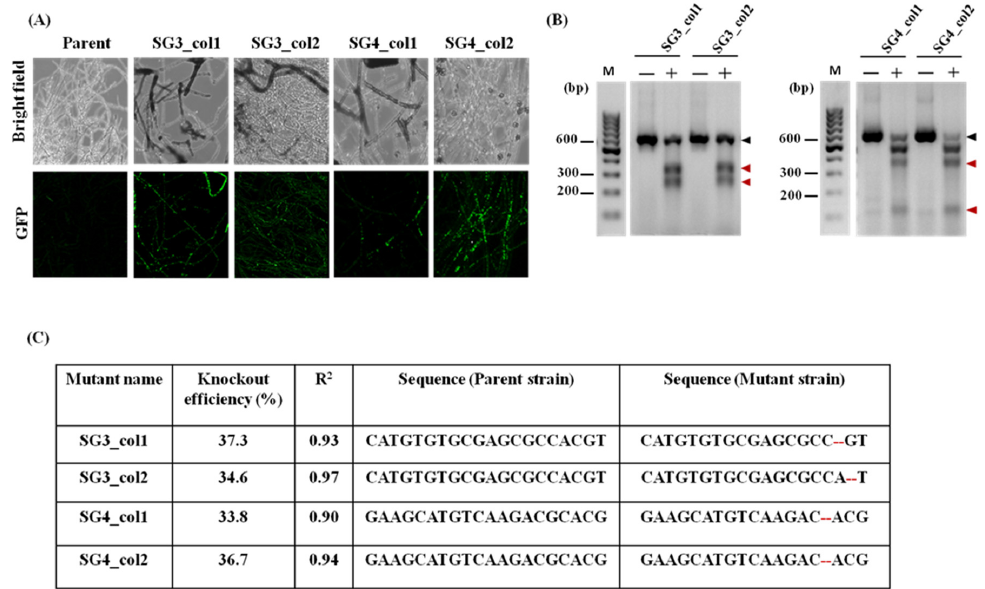
Figure 3. Generation of pacC mutants of T. rubrum IGIB-SBL-CI1. ( A ) GFP fluorescence for two ran- domly selected mitotically stable transformants obtained with sgRNA-3 (SG3_col1, SG3_col2) and sgRNA-4 (SG4_col1, SG4_col2). BF indicates brightfield while GFP indicates fluorescence measured in the range of 500–550 nm. ( B ) T7 endonuclease (T7E1) assay for transformants SG3_col1 and SG3_col2 (left panel) as well as SG4_col1 and SG4_col2 (right panel) confirms targeted NHEJ repair in pacC in all four transformants. Uncleaved DNA is indicated by black arrows and the cleaved products by red arrows. Sizes of uncut and cleaved products are given in Table S2. ( C ) The frequency of mutations along with indels, as identified by TIDE and ICE analysis tools, are indicated. The goodness of fit for the sequence trace decomposition, R 2 , as estimated by TIDE [37] is also